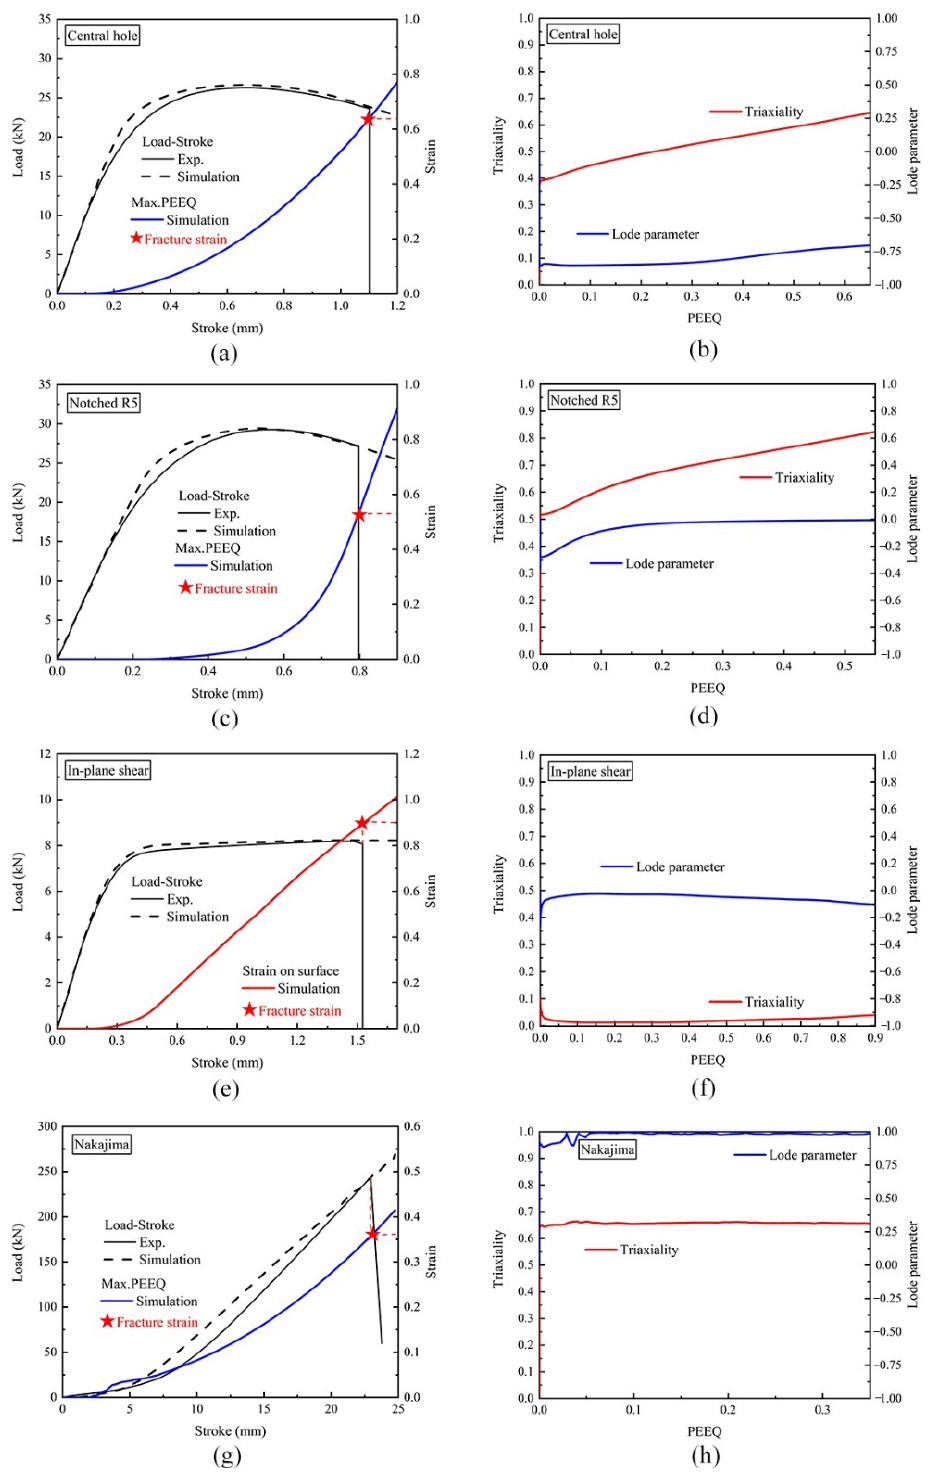
Figure A1. FE simulation results of tensile process for different martensite specimens: ( a ) central hole, ( c ) notched, ( e ) in-plane shear, and ( g ) Nakajima specimen simulated load–stroke curves and PEEQ distribution, compared with experimental results; ( b ) central hole, ( d ) notched, ( f ) in-plane shear, and ( h ) Nakajima specimen calculated evolutions of the Lode parameter and the triaxiality towards PEEQ.